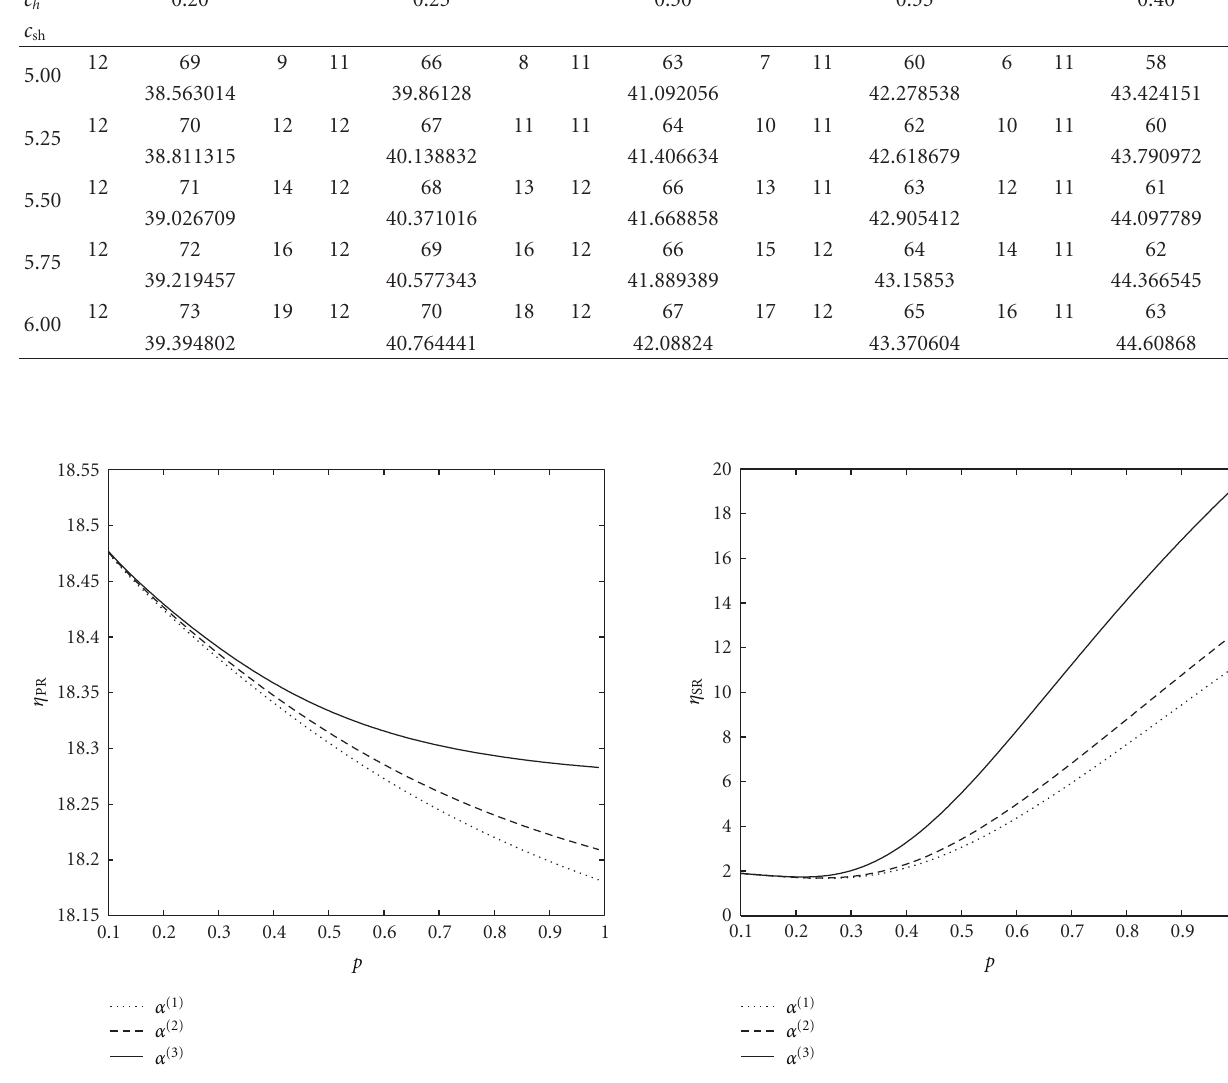
Figure 10: Expected perishable rate— p versus α ( n ) ( S = 90, s = 15, N = 25, λ = 8, β = 1 . 4, γ = 0 . 7, μ = 0 . 8 . )